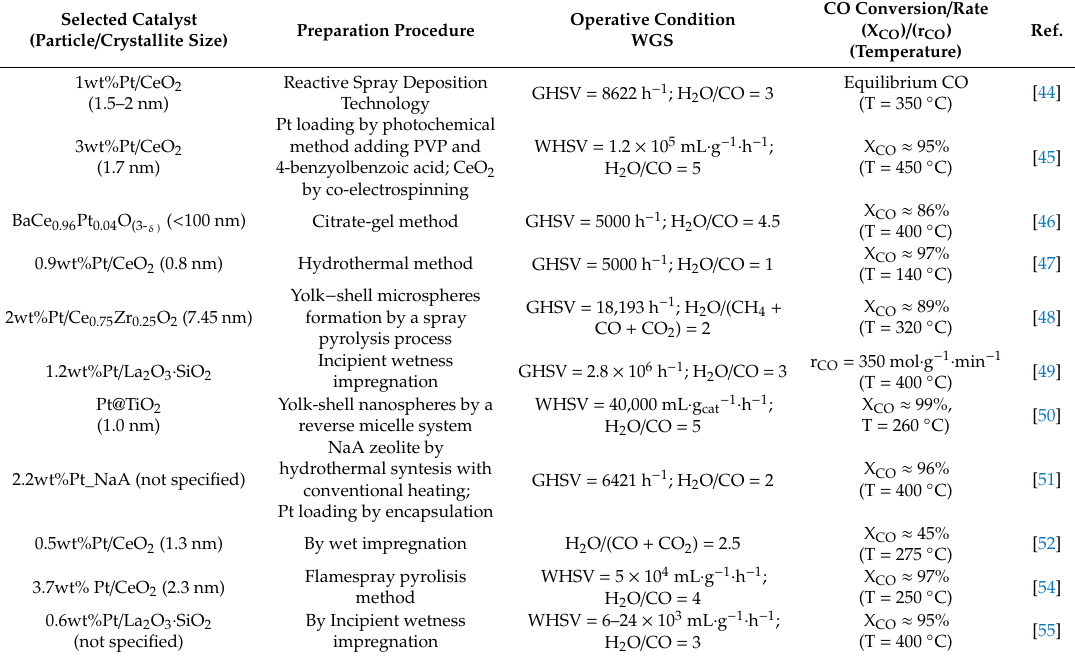
Table 2. Selected catalysts per article reported in Section 2.2: Monometallic Catalysts: the Active Phase. Selected Catalyst (Particle / Crystallite